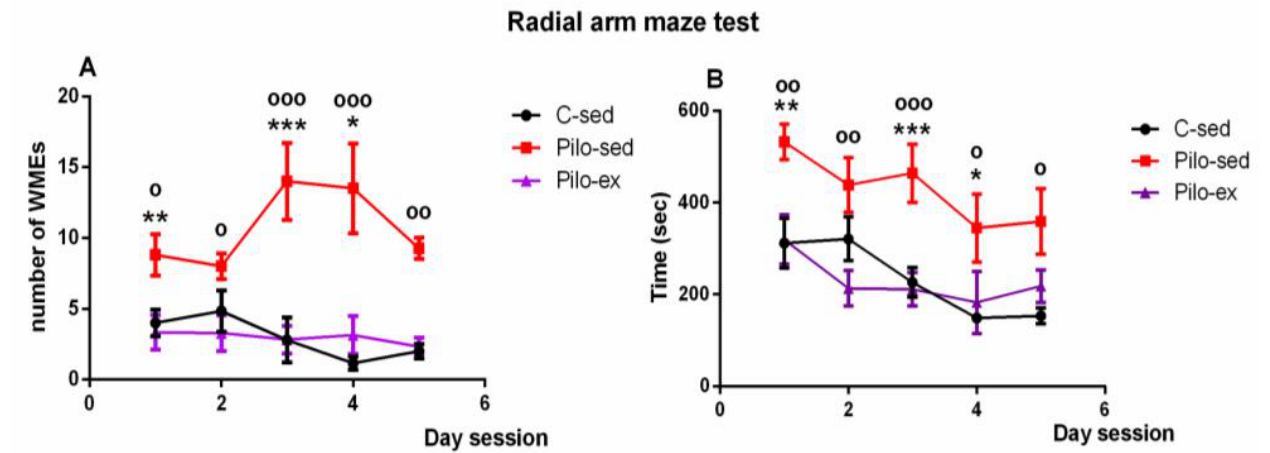
Figure 4. Effect of endurance training, applied before and after SE, on ( A ) the number of working memory errors; * p = 0.047, ** p = 0.007, *** p = 0.001 in comparison with the C-sed group; o p < 0.05, oo p = 0.002, ooo p < 0.001 in comparison with the Pilo-sed group, and ( B ) on the time (s) necessary to fulfill the task in the radial arm maze test in a pilocarpine-induced model of temporal lobe epilepsy. * p < 0.05, ** p < 0.01, *** p < 0.001 in comparison with the C-sed group; o p < 0.05, oo p < 0.01, ooo p < 0.001 in comparison with the Pilo-sed group.